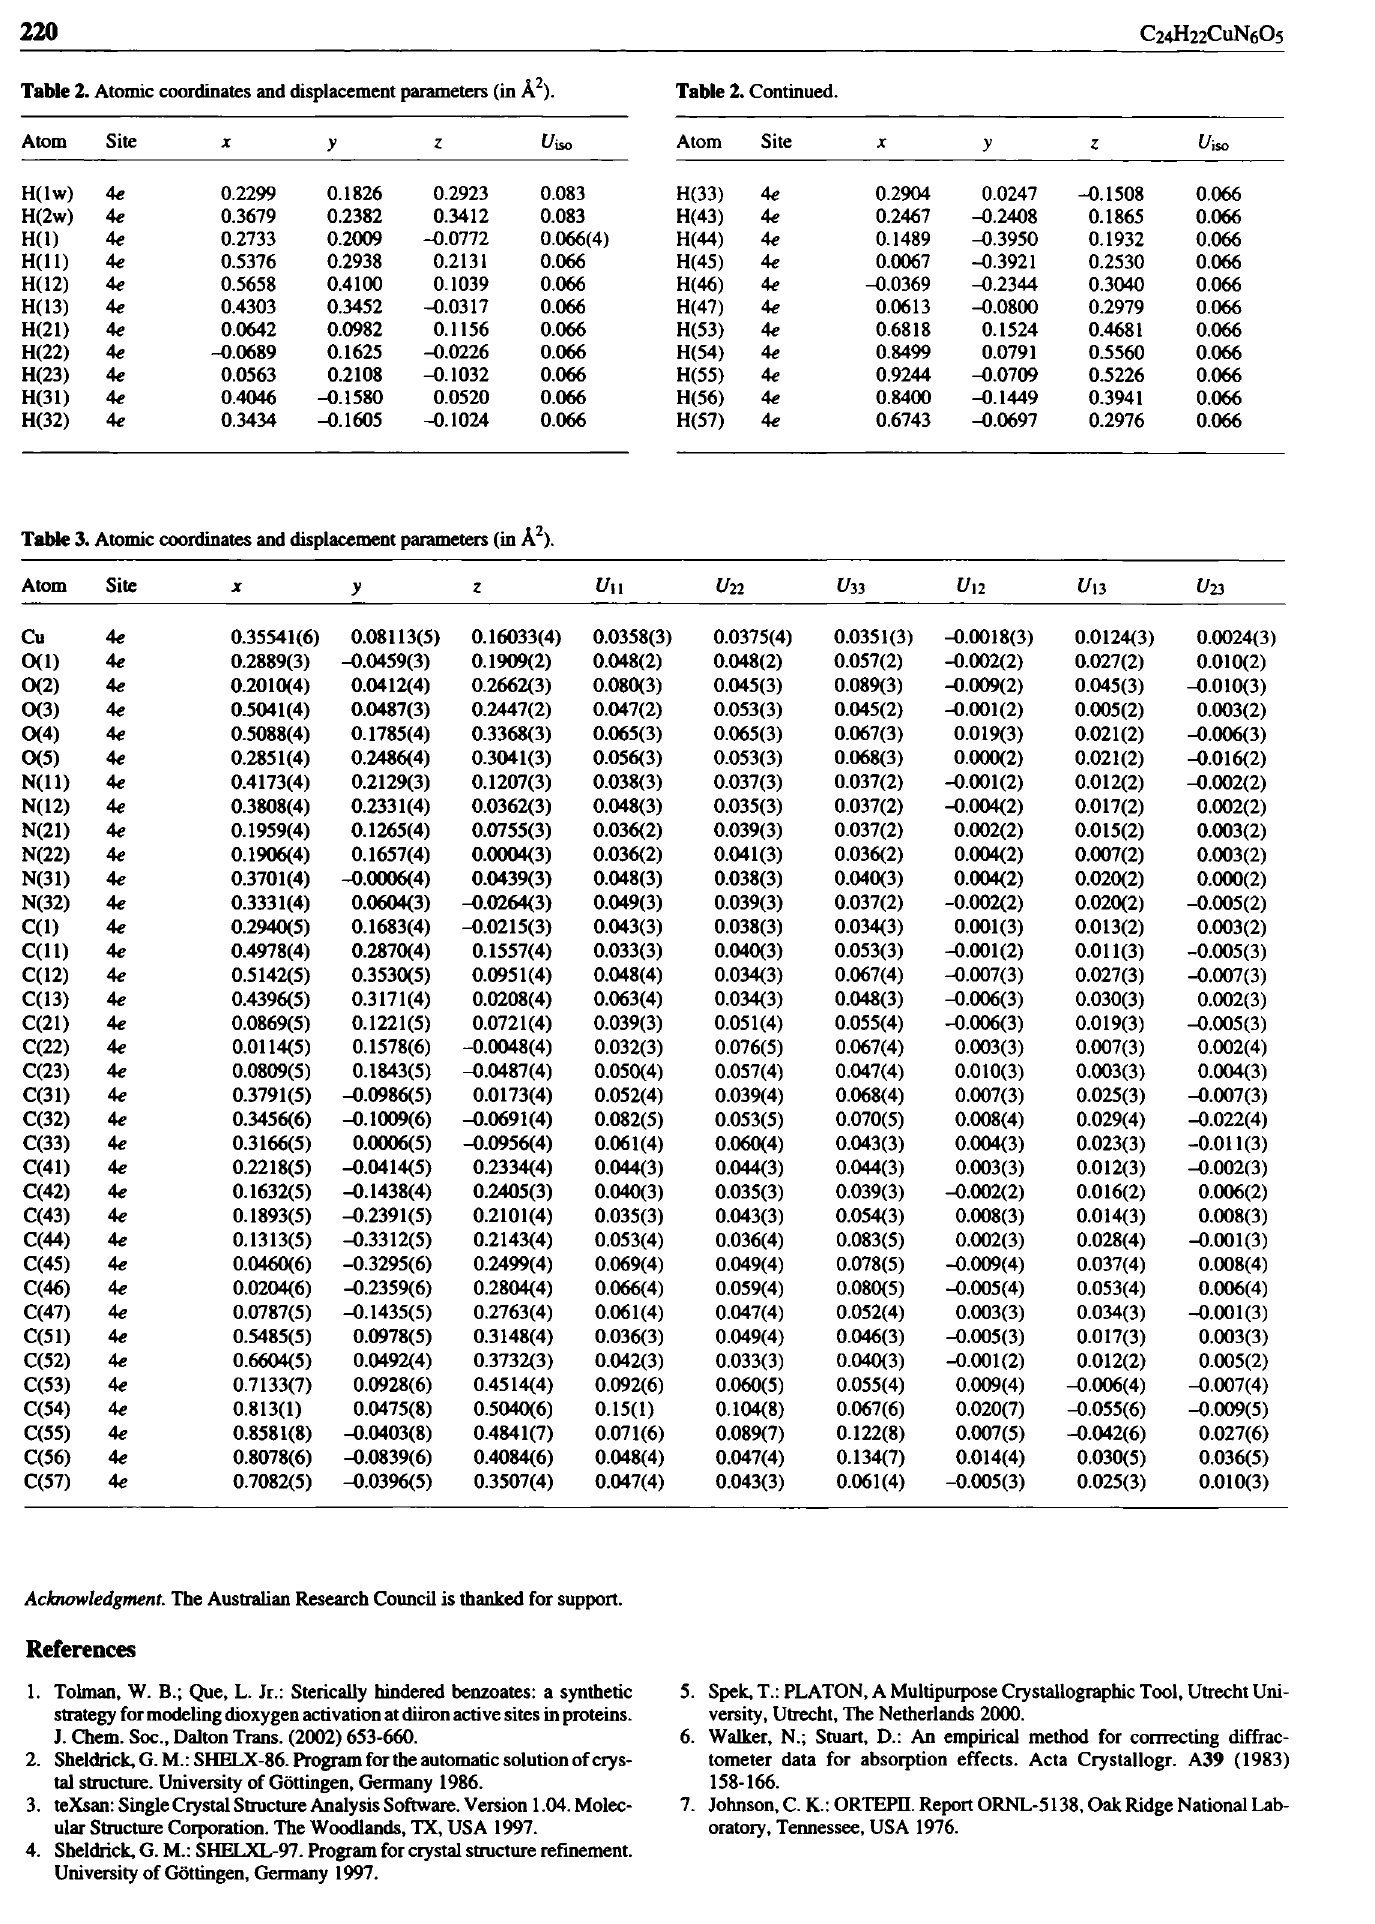
Table 3. Atomic coordinates and displacement parameters (in Â 2